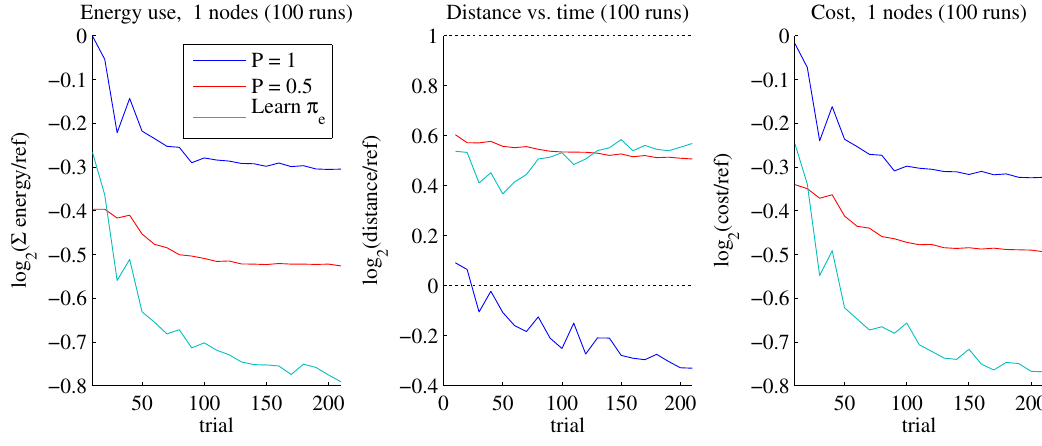
Figure 10. Node energy use with power policy initialised with θ = [ 1 0 ] T on a single node with no position error, data requirement of 10, and the soft maximum trajectory length set to twice the reference trajectory’s length for each problem. Three cases are shown: learning only for waypoint positions and transmitting at full power ( P = 1 ); learning only for waypoint positions but transmitting at ( P = 0 . 5 , “Half-power”); and learning for both waypoint positions and power policy (Learn π ). ( Left ) Energy use through time. ( Middle ) e Trajectory length through time—the dotted line at 1 is the soft trajectory length limit. ( Right ) Composite trajectory cost through time (defined by Equation (16)). We use cost = − reward here to make the graph’s trend more intuitive. Note that all y-axes are log